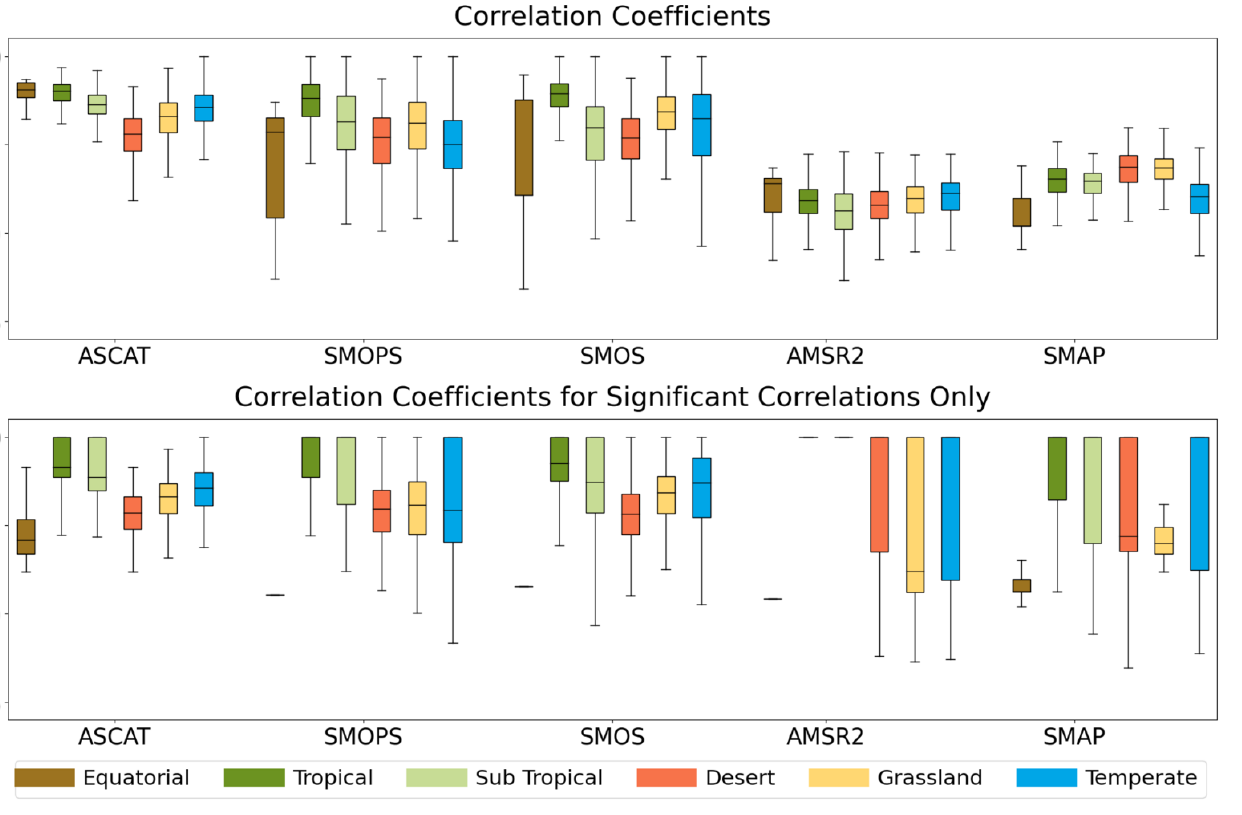
Figure 12. Spatial correlation coefficients for ASCAT, SMOPS, SMOS, AMSR-2, and SMAP sectioned by climate zone—whiskers extend out to show the interquartile range; the black bar indicates the median value of the distribution.